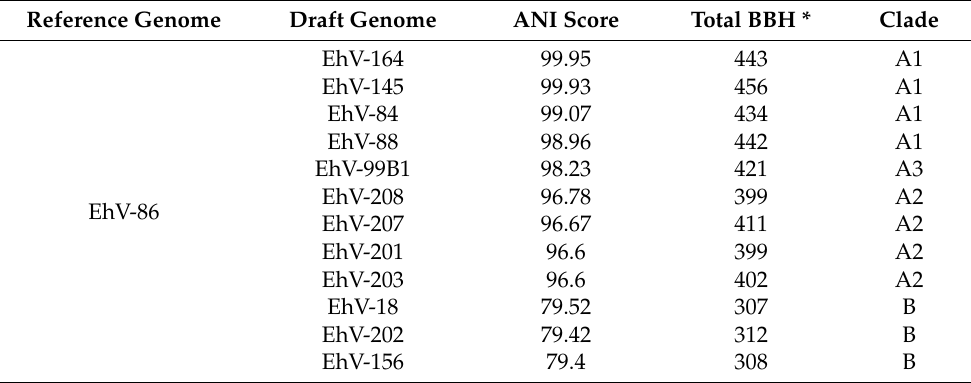
Table 2. Average Nucleotide Identity (ANI) analysis of EhV genomes against EhV-86. The analysis included 12 draft EhV genomes, where a higher ANI score indicates greater genome